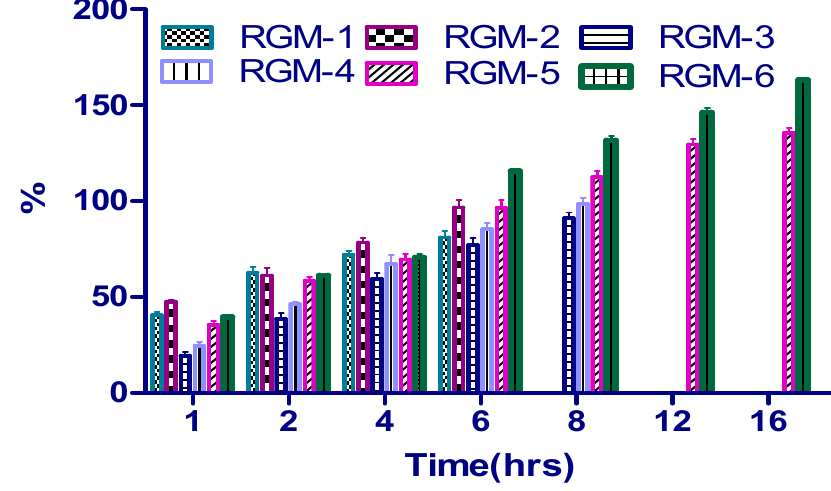
Figure 6. Swelling index profile for RGM-1 to RGM-6.